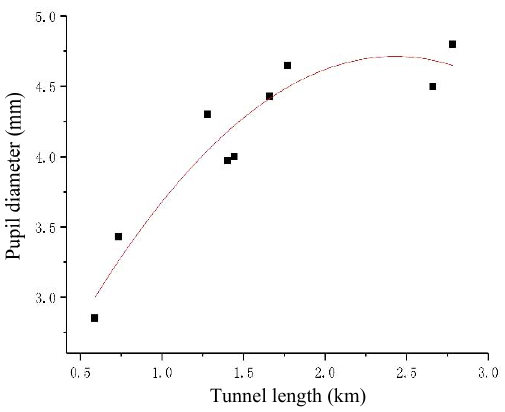
Figure 7. The fitted curve of tunnel length and maximum pupil diameter.